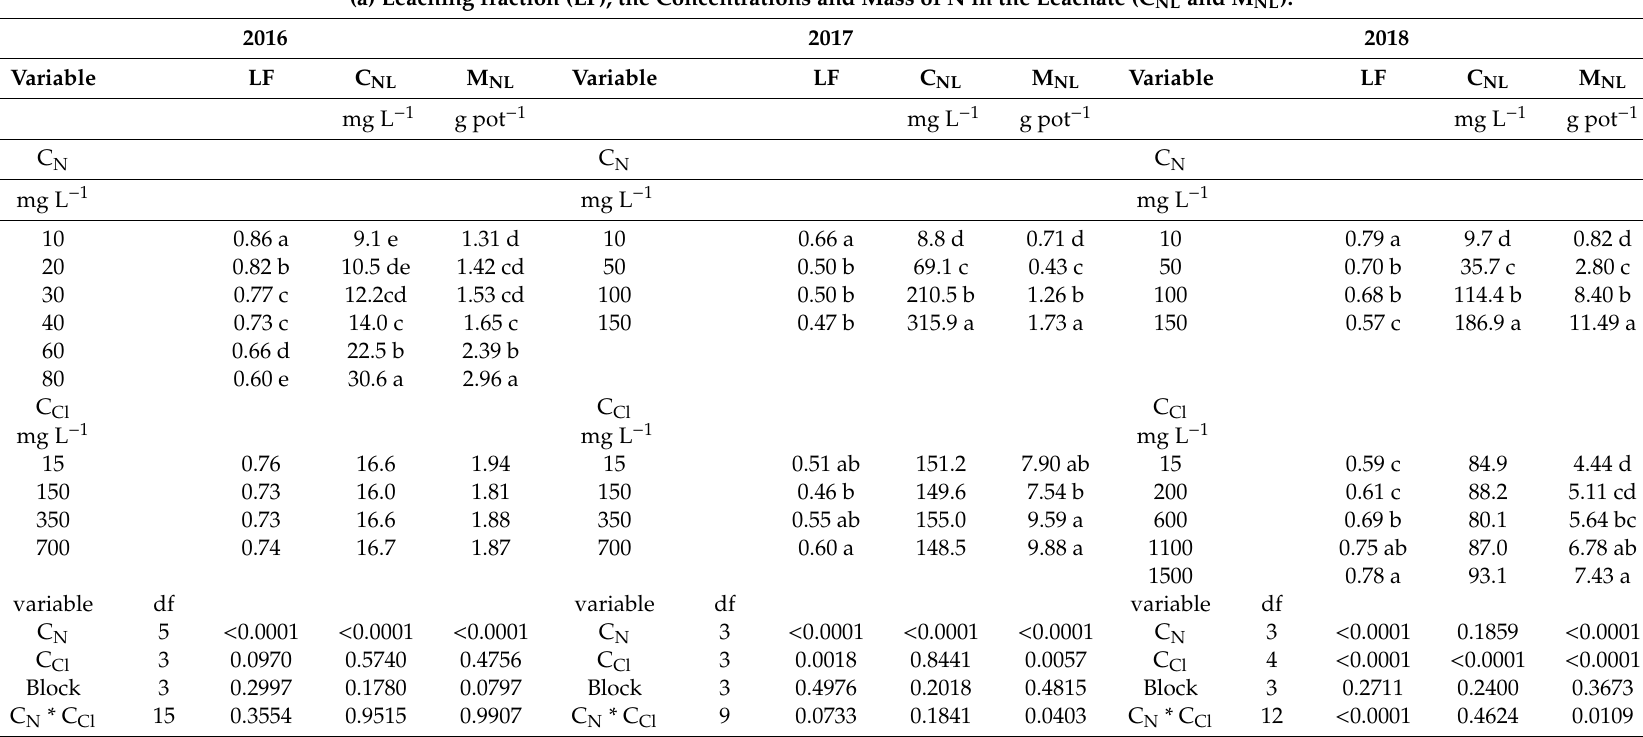
Table 9. The e ff ects of C N and C Cl on ( a ) leaching fraction (LF) and the concentrations and mass of N in the leachate (C NL and M NL ), and ( b ) the concentrations and the mass of Cl in the leachate (C ClL and M ClL ) in the potato experiments. The probability of F values for C N , C Cl , block factors, and the interaction of C N and C Cl was determined using the two-way ANOVA procedure of JMP 14. Di ff erent letters on the right side of values indicate significant di ff erence between treatments (HSD) at p < 0.05 by the Tukey–Kramer honestly test. No letters are presented when no significant di ff erence was